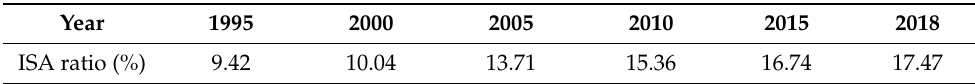
Table 4. ISA Expansion Intensity Index from 1995 to 2018.